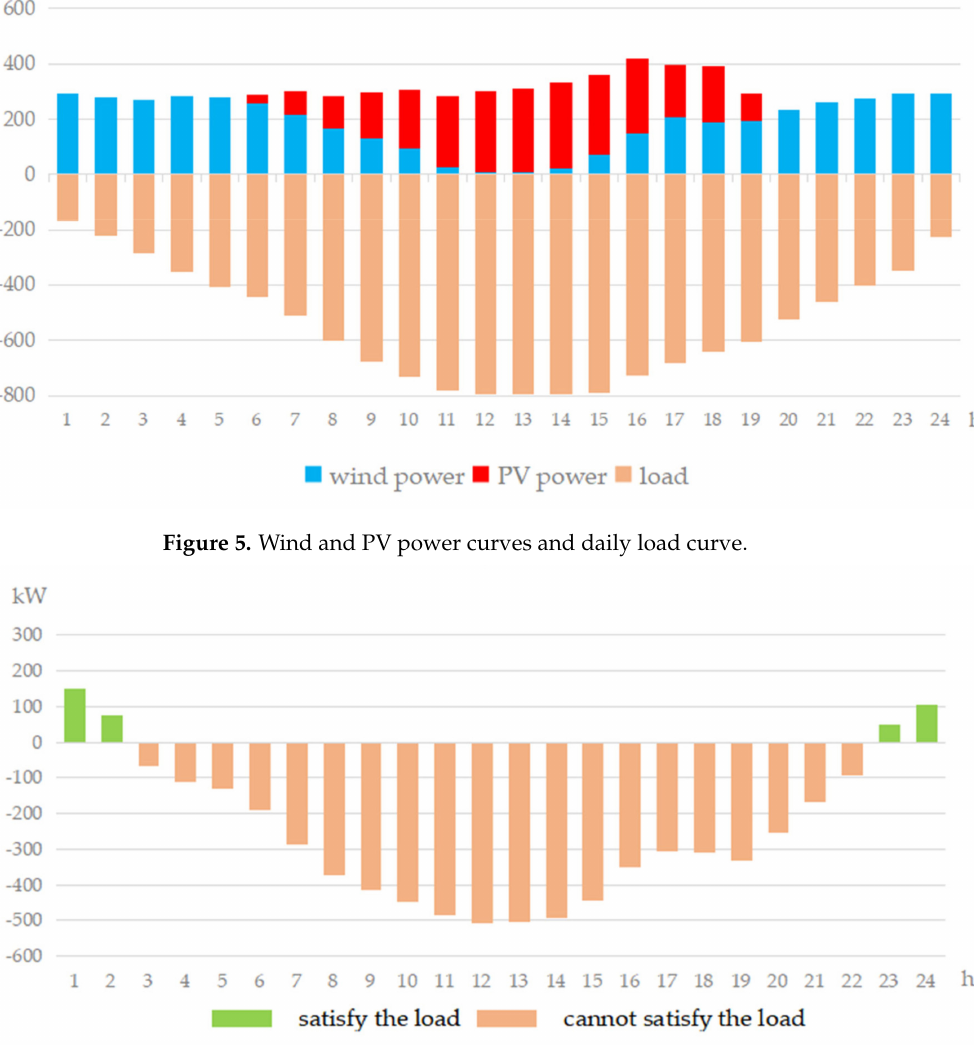
Figure 6. Supply-to-load curve of wind and PV power.